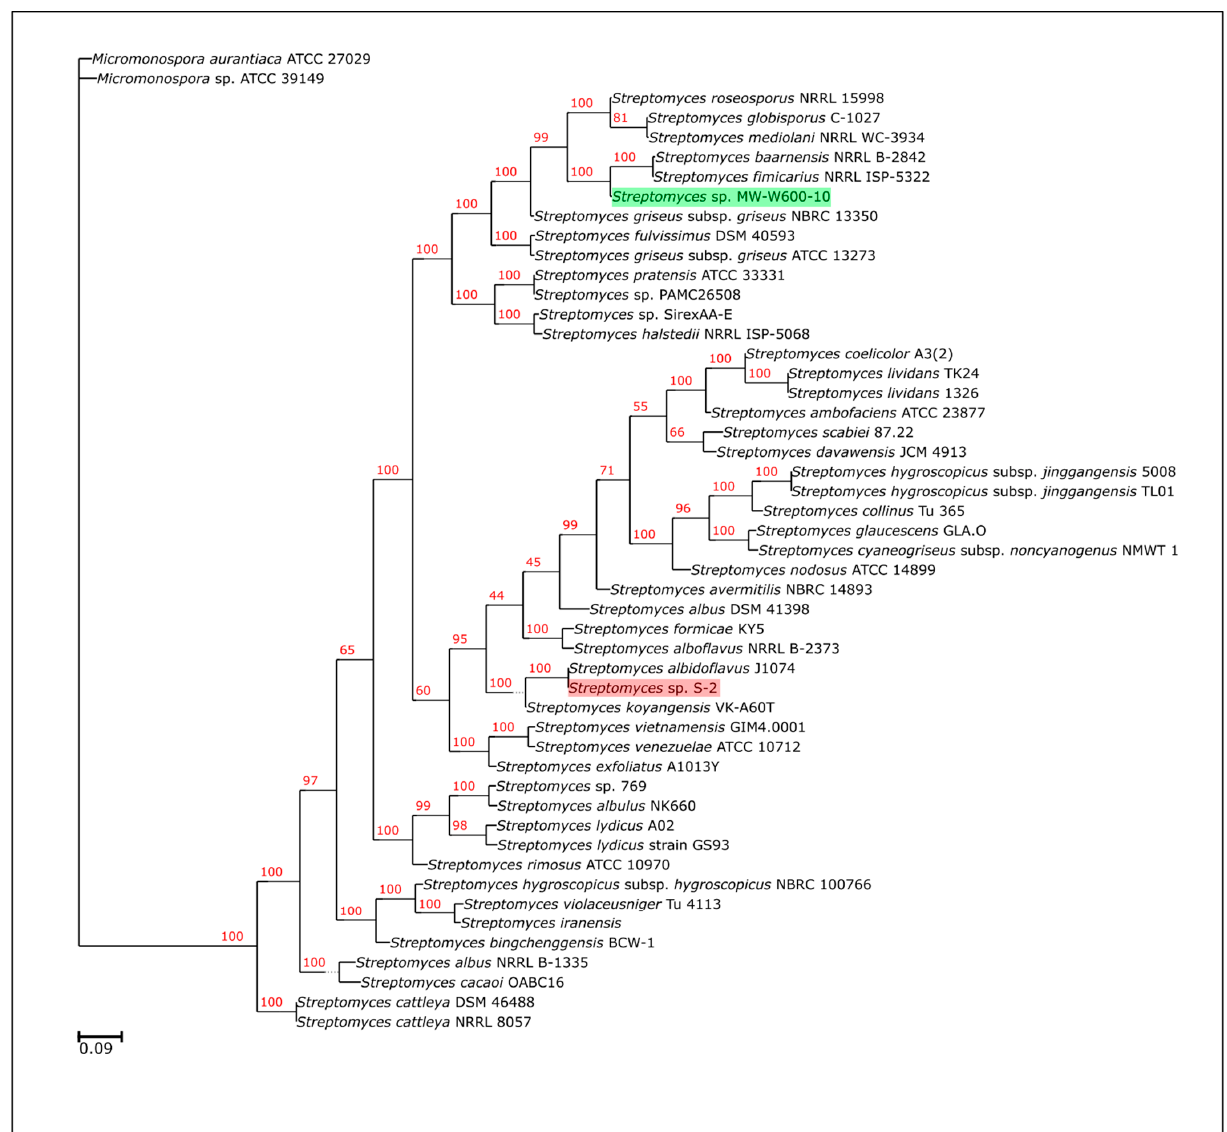
Figure 1. Maximum-likelihood phylogenetic tree of the Streptomyces sp. MW-W600-10 strain. The tree shows the phylogenetic relation between MW-W600-10 and other Streptomyces strains. The tree was calculated using IQ-TREE software based on the alignment of core proteomes of 50 Actinobacteria strains, and Micromonospora strains were used as an outgroup. Numbers at the nodes in red represent bootstrap values (% of 1000 repeats). The position of MW-W600-10 has been highlighted in green; the position of another coal-related strain, Streptomyces sp. S-2, has been highlighted in red for better visibility.